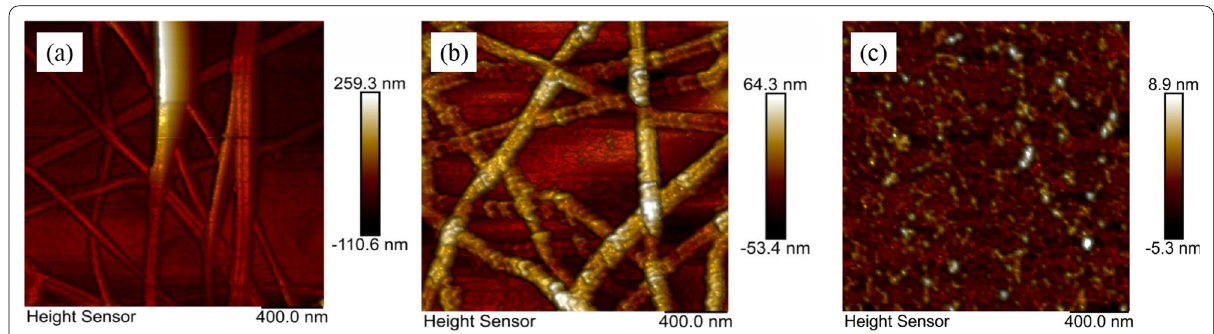
Fig. 8 AFM topographic images of a CuNW TCF, b CuNW/MoS2 CTCF, c CuNW/MoS 2 / PEDOT:PSS CTCF